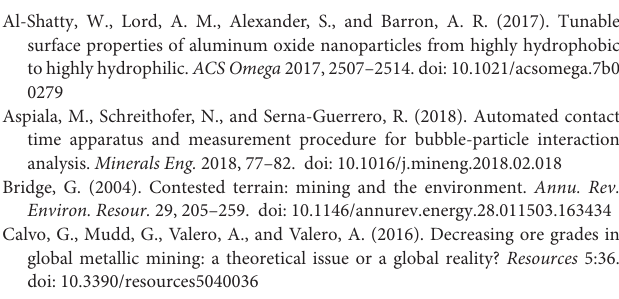
FIGURE S1 | The probability for an attachment between a QRZ particle and an air bubble immersed in a NaCl or MgSO 4 solution at pH 5 over the particle-bubble compression for different contact times and HAC concentrations. FIGURE S2 | The probability for an attachment between a QRZ particle and an air bubble immersed in a NaCl or MgSO 4 solution at pH 9 over the particle-bubble compression for different contact times and HAC